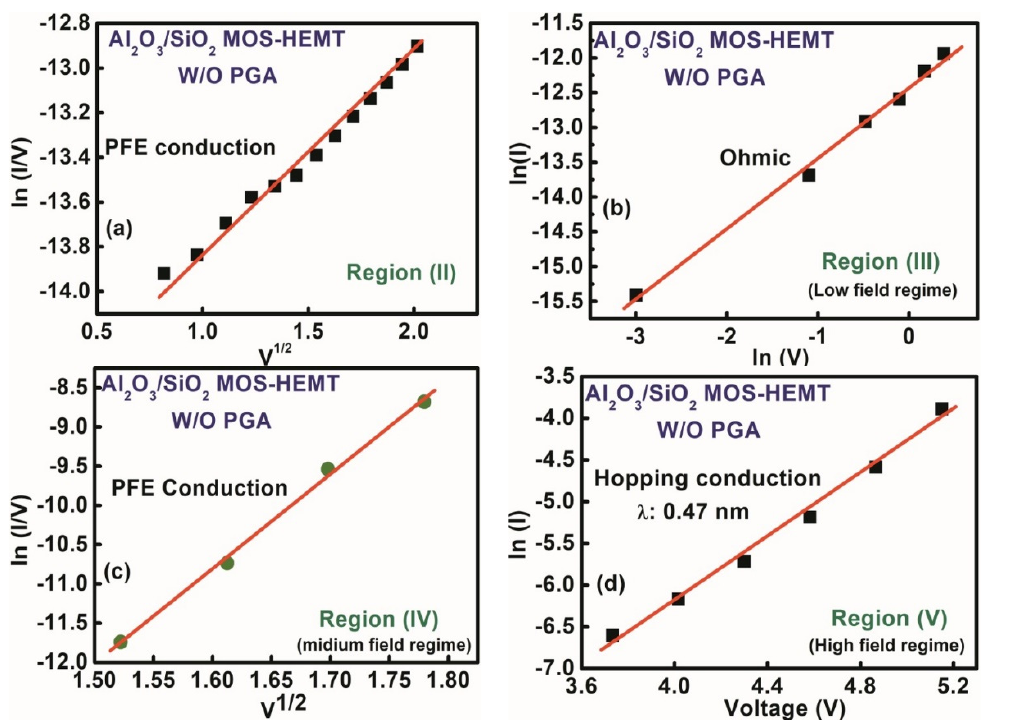
Figure 9. Gate leakage conduction mechanism of the Al 2 O 3 /SiO 2 MOS–HEMT before gate annealing treatment ( a ) region II, ( b ) region III, ( c ) region IV, ( d ) region V.